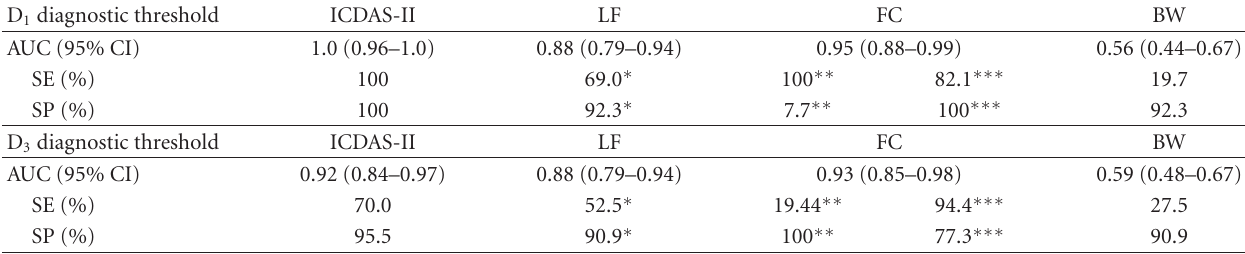
Table 3: The area under the ROC curve (AUC), sensitivity (SE), and specificity (SP) for each method at the D 1 and D 3 diagnostic thresholds. D 1 diagnostic threshold